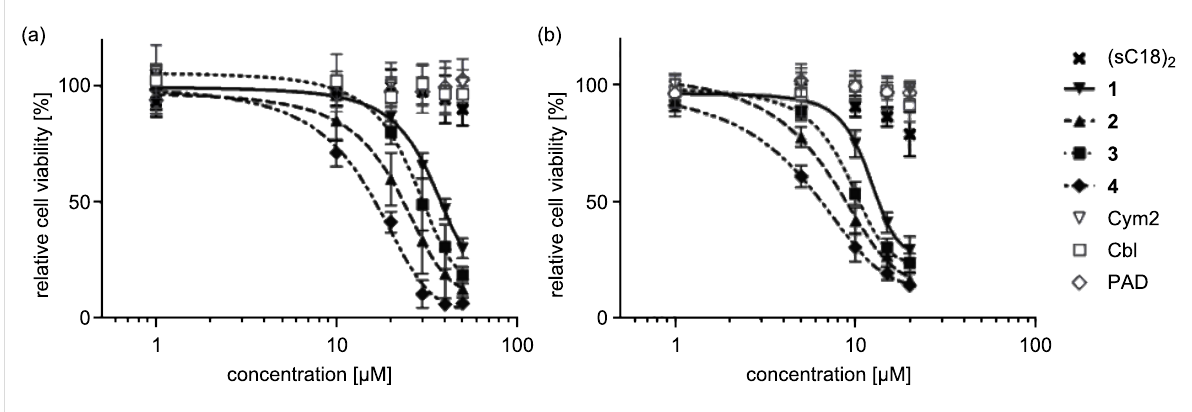
Figure 7: Cell viability of (a) HT-29 and (b) MCF-7 cells after 24 h incubation with the (sC18) 2 conjugates at different concentrations, as determined by a resazurin-based cell viability assay. Experiments were conducted in triplicate with n = 2. Error bars represent standard deviation. Curves obtained by nonlinear regression (sigmoidal dose–response). For IC 50 values see Table 2.